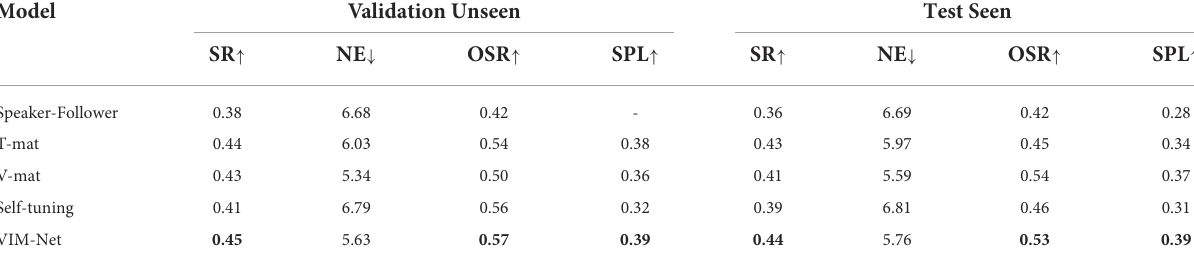
TABLE 4 The ablation study of our proposed architecture on the R2R validation set and our baseline model is the Speaker-Q14 Follower model.